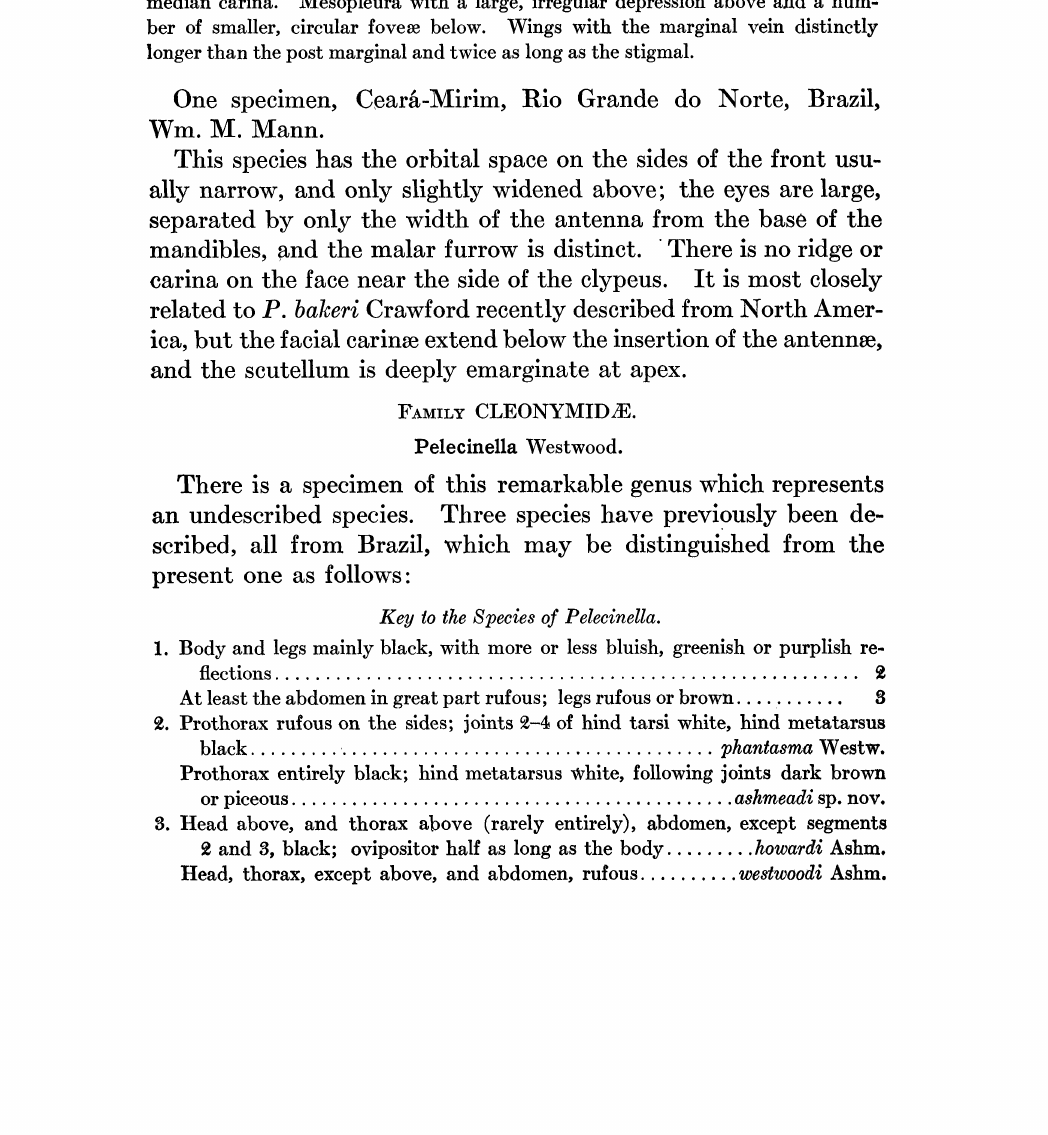
yellowish white, with the extreme tip dark. Wings hyaline. Occiput behind the ocelli finely, irregularly transversely striate and finely shagreened forward to the level of the anterior ocellus. Facial basin smooth and polished, margined laterally by a raised line that separates it from the narrow orbits and curves inward above to include the anterior ocellus. Lower corners of facial basin striated, their strise extending upwards for a short distance along the orbits. Clypeus with a few large shallow punctures; face at sides of clypeus minutely rugulose; gene vertically striated, these striee extending upwards to meet those on the occiput. Thorax and scutellum umbilicately punctate except for the axille and a space external to each parapsidal furrow. Scutellum with a carinate margin .that is emarginate at tip to form two blunt teeth. Tegule rufo-fuscous. Metathorax with a strong median carina. Mesopleura with a large, irregular depression above and a num- ber of smaller, circular fovee below. Wings with the marginal vein distinctly longer than the post marginal and twice as long as the